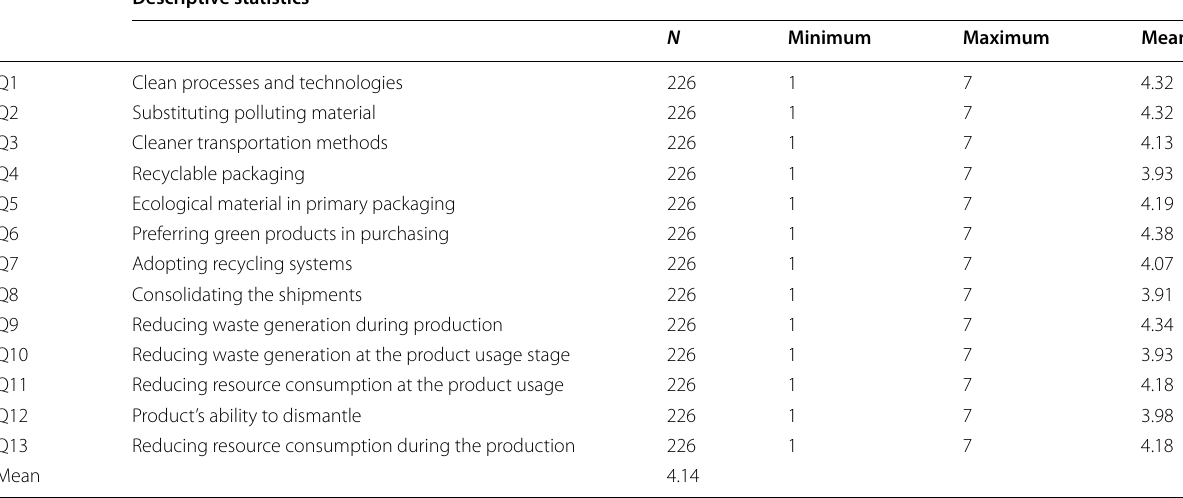
Table 2 Descriptive statistics of green